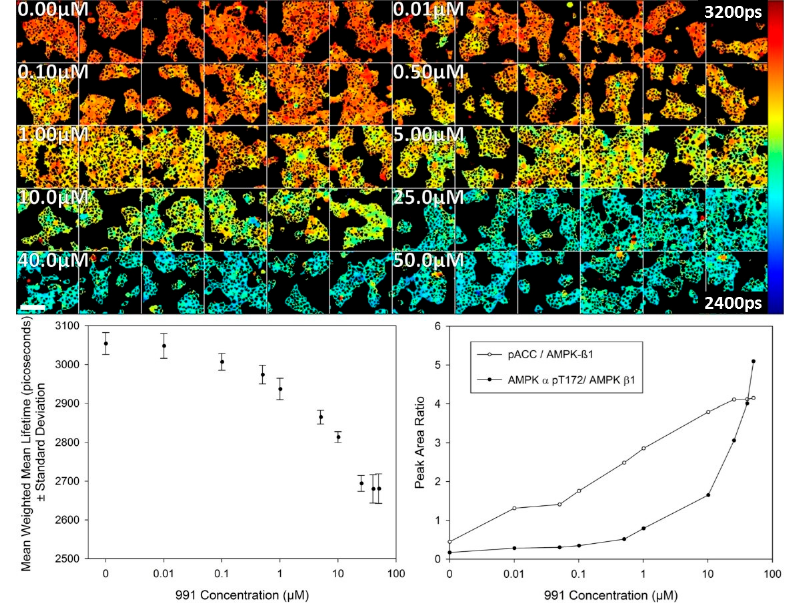
Figure 4. T2AMPKAR-NES dose response to 991. Upper panel : montage of confocal TCSPC FLIM maps of the weighted mean lifetime for the dose response; Lower left panel : plot of the mean weighted mean lifetime dose response for 991 (n = 6); Lower right panel : AMPK activity detected by automated Western blotting (WES) of AMPK α phosphothreonine-172, phospho-ACC and AMPK β . Lifetimes are shown in picoseconds (shown in image). Scale bar = 100 µm.